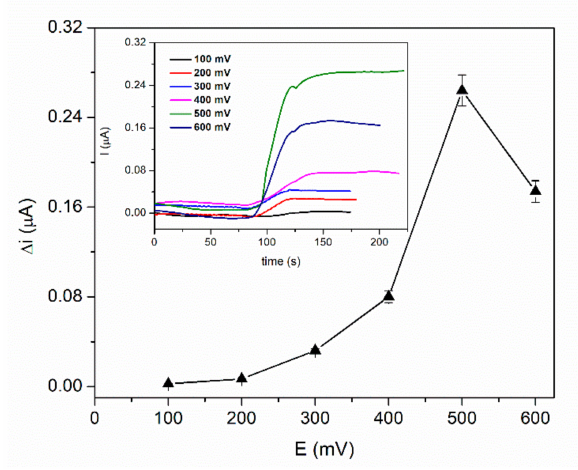
Figure 4. Influence of working potential on the biosensor response (PBS 0.1 M pH = 7.5, 8 mM NAD + , 2 mM L-lactic acid, n = 3). (inset: chronoamperometric response curves at an applied potential between 100 and 600 mV).